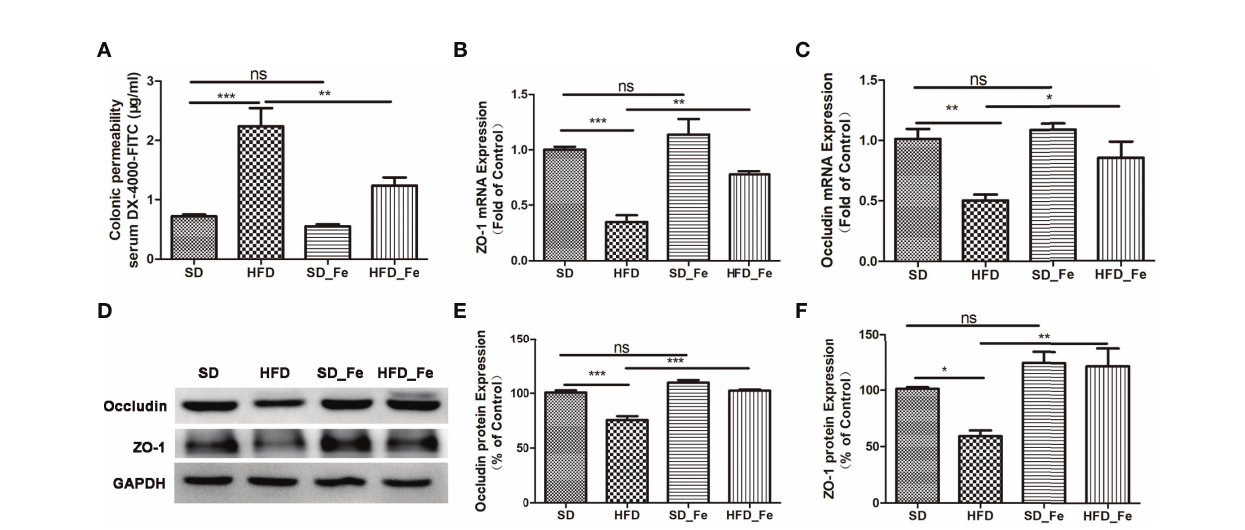
FIGURE 1 | Feno fi brate improved intestinal barrier function in high-fat diet (HFD)-fed mice. (A) Colonic permeability assay: serum DX-4000-FITC ( m g/mL). (B, C) ZO-1 (B) and Occludin (C) mRNA expression levels in colonic tissue. (D – F) Representative images and statistical analysis of Western blot showed the Occludin (D, E) and ZO-1 (D, F) protein levels in colonic tissue. SD group, standard diet group; HFD group, high-fat diet group; SD_ Fe group, standard diet plus feno fi brate group; HFD_ Fe group, high-fat diet plus feno fi brate group. n = 5; ns, not signi fi cant; *P < 0.05; **P < 0.01; ***P < 0.001. Bar graphs represent mean values ±